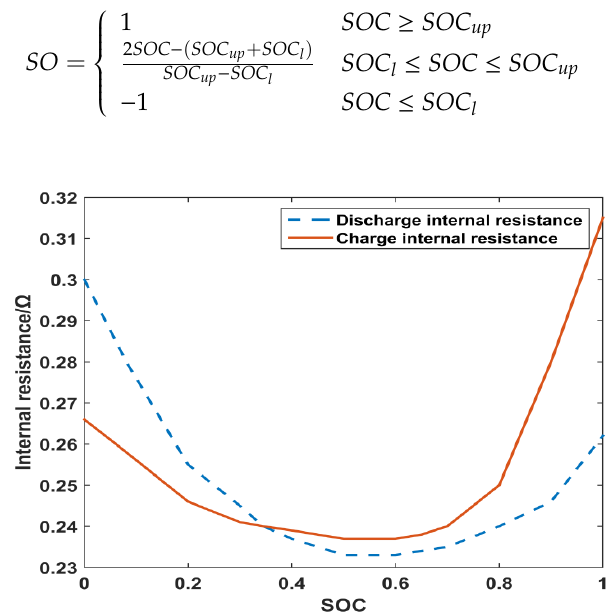
Figure 3. Relationship between battery SOC and resistance.